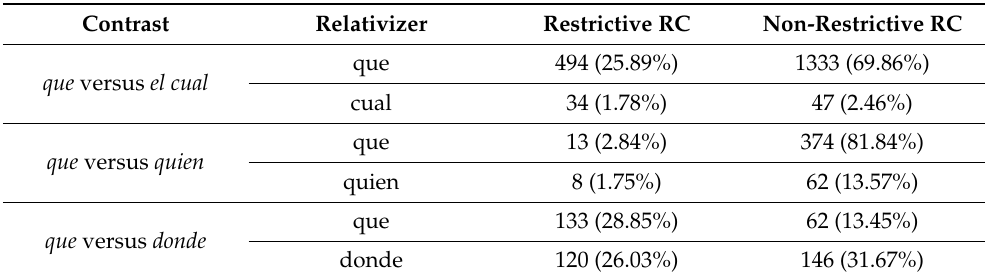
Table 2. Absolute and relative frequencies (in parentheses) of relativizers in restrictive and non- restrictive RCs according to the three contrasts of interest: que versus el cual , que versus quien , and que versus donde . Relative frequency was calculated over the total number of relativizers in the contexts where two of them can vary.